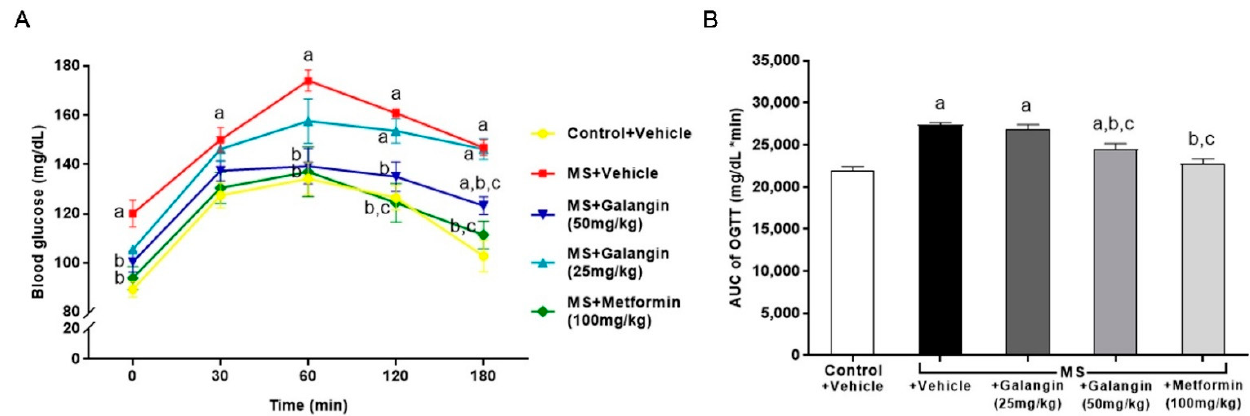
Figure 1. Effects of galangin and metformin treatments on blood glucose concentrations: ( A ) oral glucose tolerance test (OGTT) and ( B ) and area under the curve (AUC) of OGTT. Data are presented as the mean ± S.E.M. ( n = 8). a p < 0.05 vs. the control group, b p < 0.05 vs. the MS group, and c p < 0.05 vs. MS + the galangin (25 mg/kg) group. Table 2. Effects of galangin and metformin treatments on metabolic parameters in rats with high-fat diet-induced metabolic